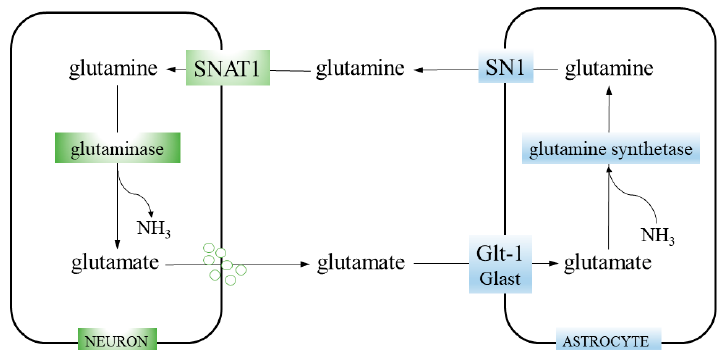
Figure 1. Glutamine–glutamate cycle. Neurons take up glutamine from the extracellular space through the SNAT1 transporter. Then, glutamine is hydrolyzed to glutamate and ammonia by glutaminase. Glutamate is packed into synaptic vesicles and released during neurotransmission. The glutamate is cleared from the synaptic cleft by astrocytes, employing glutamate transporters GLT-1 and, to a lesser extent, GLAST. Astrocytic enzyme glutamine synthetase catalyzes the reaction of glutamate amidation and generate glutamine. Finally, glutamine is released from astrocytes via the SN1 transporter.